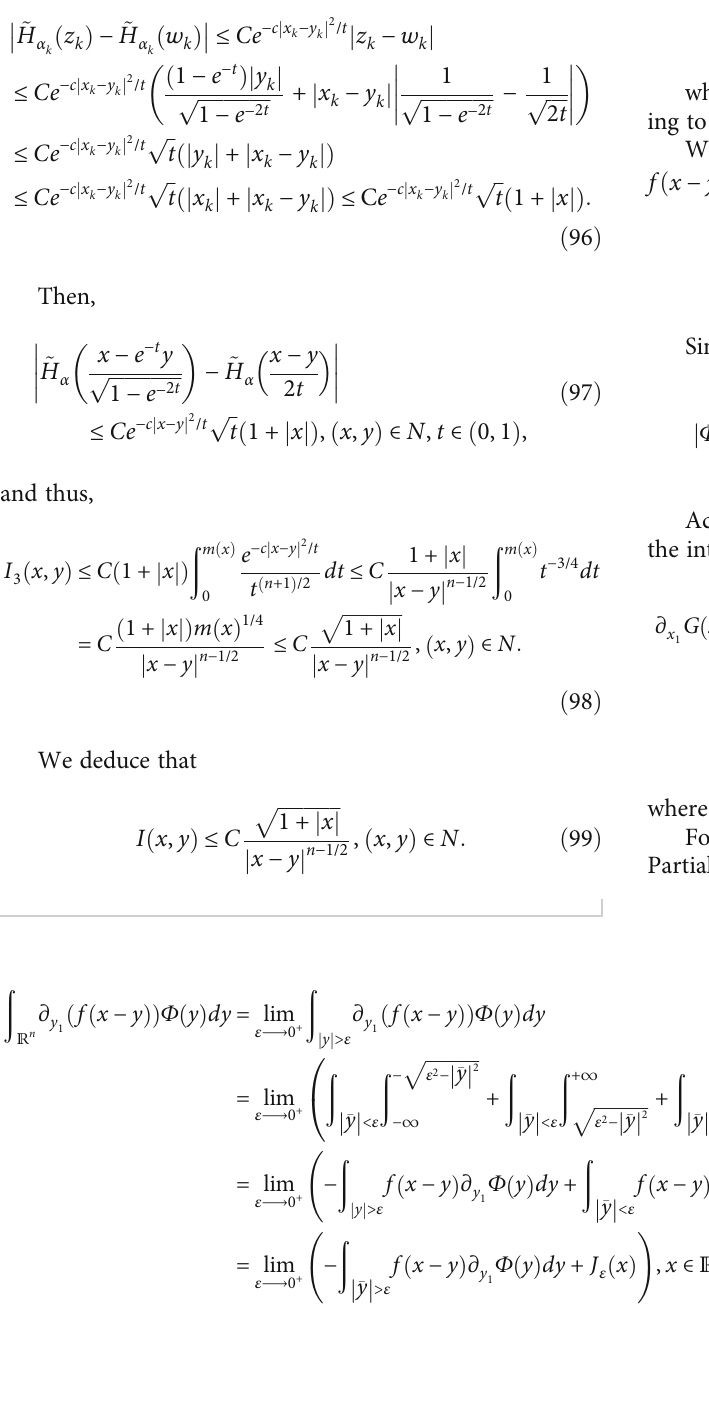
ffiffiffiffiffiffiffiffiffiffiffi ε 2 − (cid:2) y j j 2